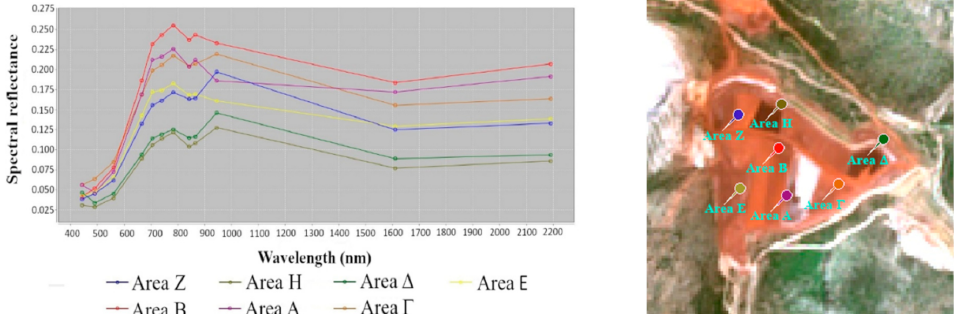
Figure 5. Sentinel-2-Images (30 July 2019) of Greece BR and the spectrum view ( left ) of selected areas ( right ).